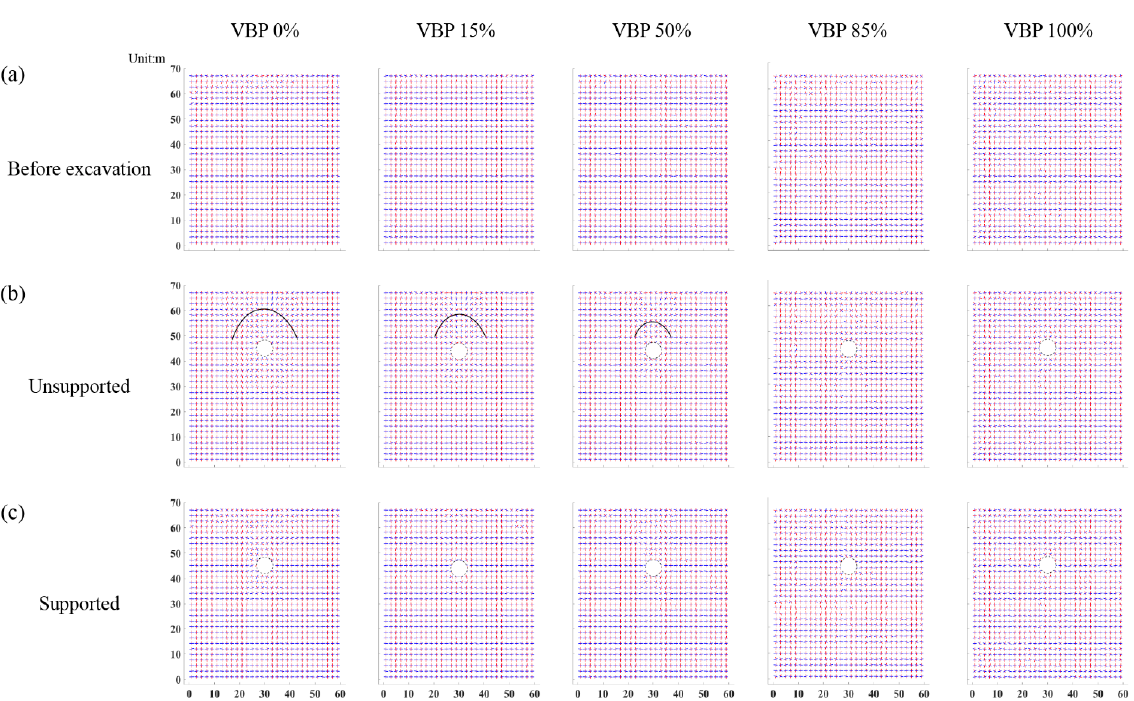
Figure 13. The distribution of vertical stresses in the computational domain: ( a ) initial state before excavation, ( b ) unsupported tunnel excavation, and ( c ) supported tunnel excavation by rigid lining.